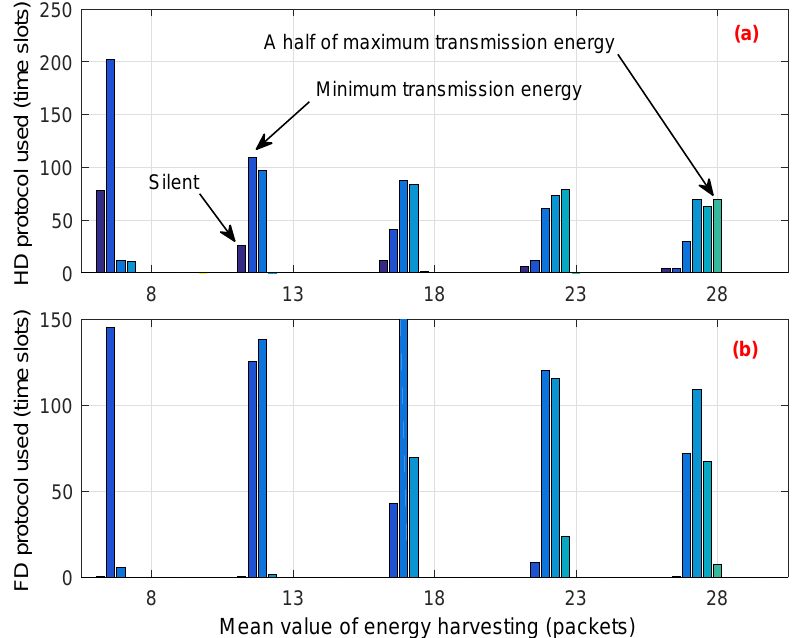
Figure 11. Statistics on the proposed scheme: average number of time slots where the CU decides to transmit using the ( a ) HD or the ( b ) FD protocol with the corresponding amounts of transmitted energy.